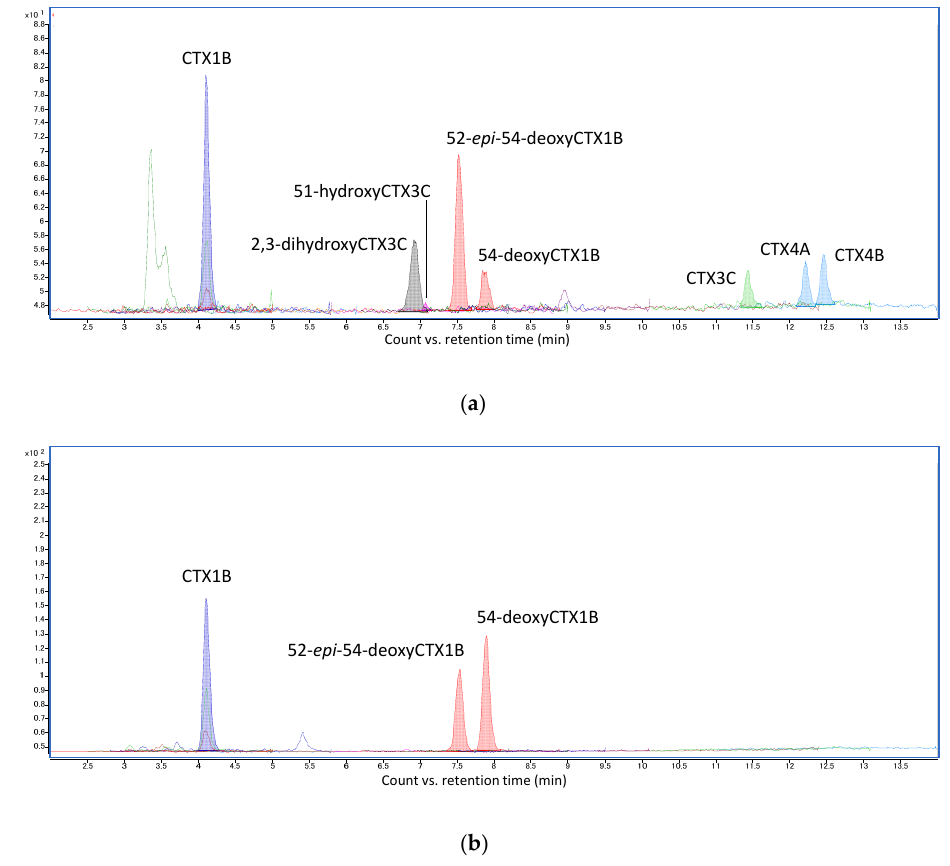
Figure 4. Representative LC-MS/MS chromatograms of ( a ) the reference CTX mixture and ( b ) the V. louti specimen (NIHS-Cig-153063).